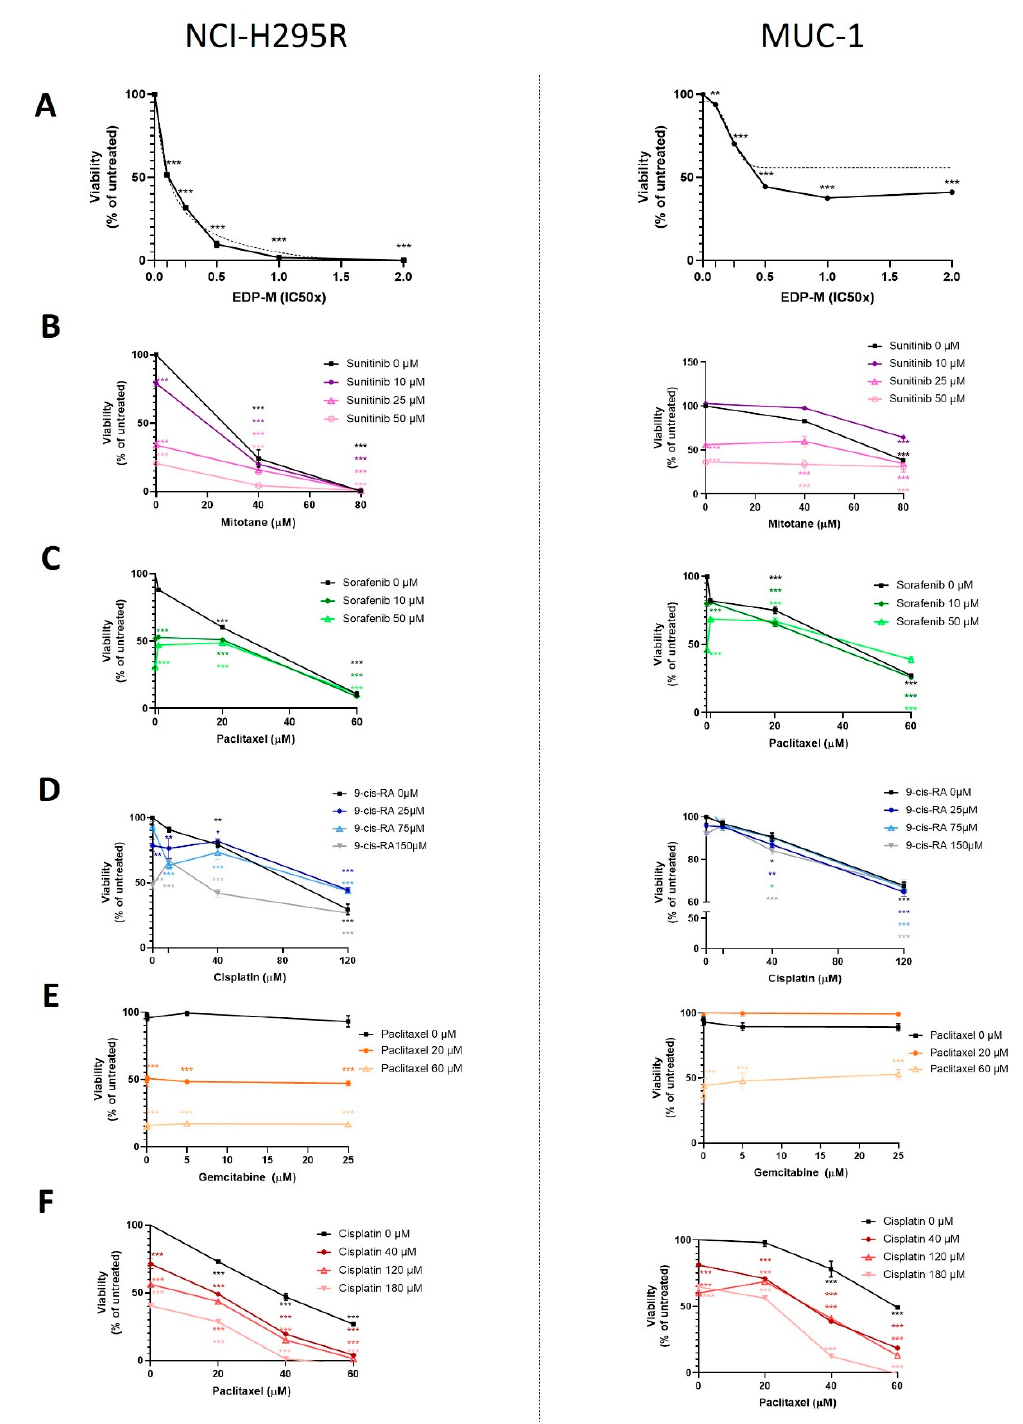
Figure 2. MTT viability assay for EDP-M combination in increasing concentrations for 24 h for NCI-H295R (left) and MUC-1 (right) cell lines ( A ). Specific concentrations for the separate drugs are outlined in detail in the result section. ( B – F ) MTT viability assays of two-drug combinations of increasing dosages vs. no drug for 24 h. Stars represent significance vs. nontreated for both treatments (*, p < 0.05; **, p < 0.01; ***, p < 0.001).